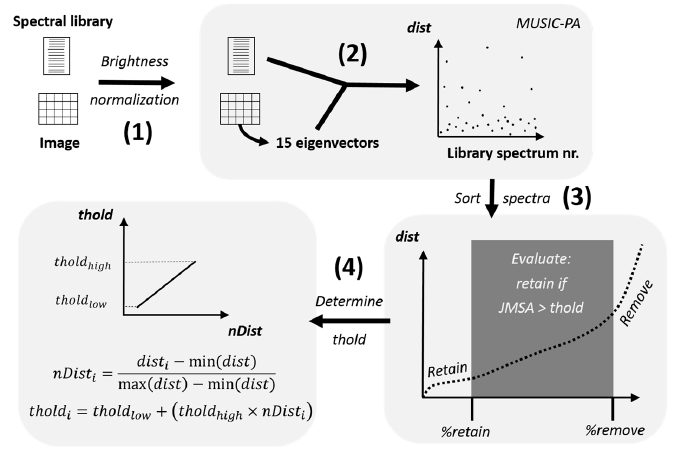
Figure 1. Workflow of the AMUSES pruning algorithm. (1) Brightness normalization is applied on the original image and spectral library to avoid the brightness bias of the original MUSIC-PA. (2) MUSIC-PA: the image is represented as 15 eigenvectors and the distance ( dist ) of each library spectrum to this set of eigenvectors is determined. (3) Spectra are sorted according to their MUSIC-PA distance. A fraction of the most relevant spectra ( %retain ) is retained, a fraction of the least relevant (%remove ) is discarded. The other spectra are evaluated using the JMSA spectral separability metric (combining Jeffries Matusita distance and Spectral Angle): a spectrum is only retained if it is sufficiently dissimilar (JMSA larger than a threshold, thold ) from the already selected spectra. (4) The JMSA threshold is determined in function of the normalized MUSIC-PA distance ( nDist ) for each spectrum: the higher the distance, the less relevant the spectrum is to the image